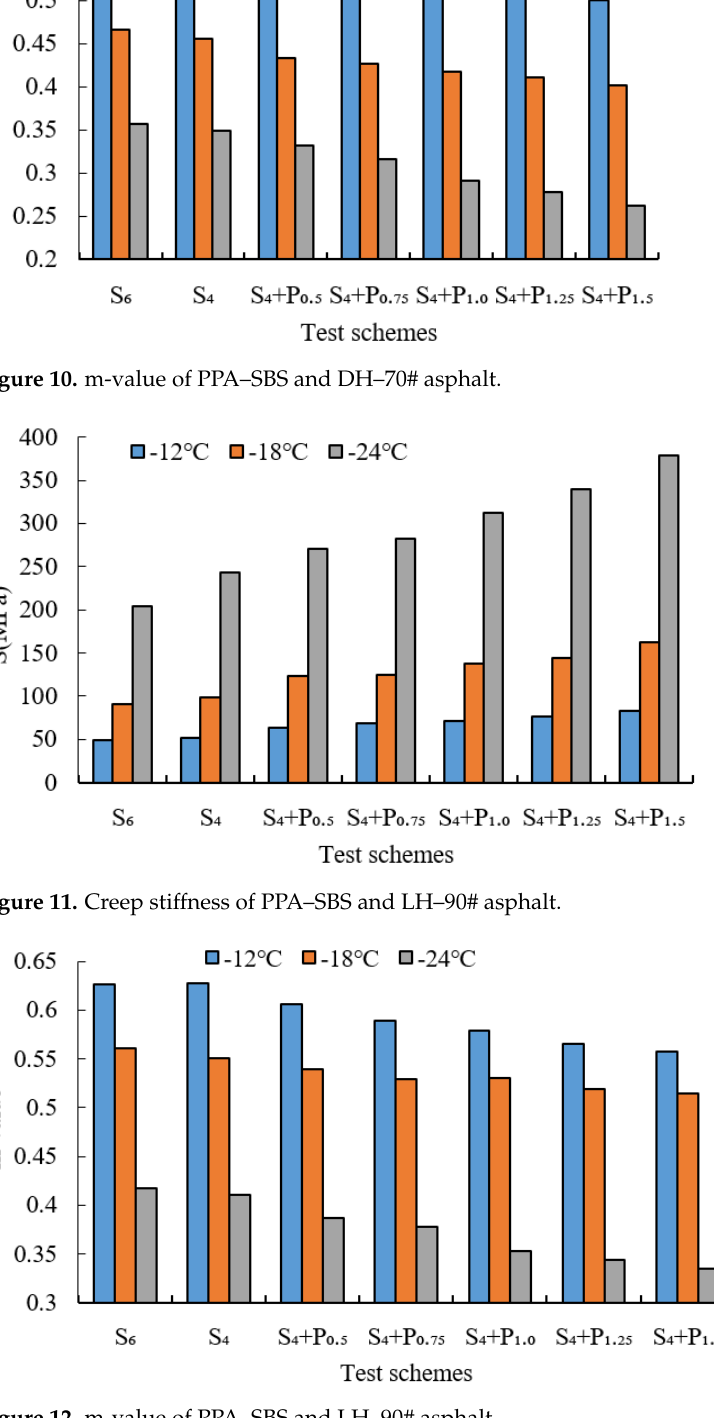
Figure 12. m-value of PPA – SBS and LH – 90# asphalt.